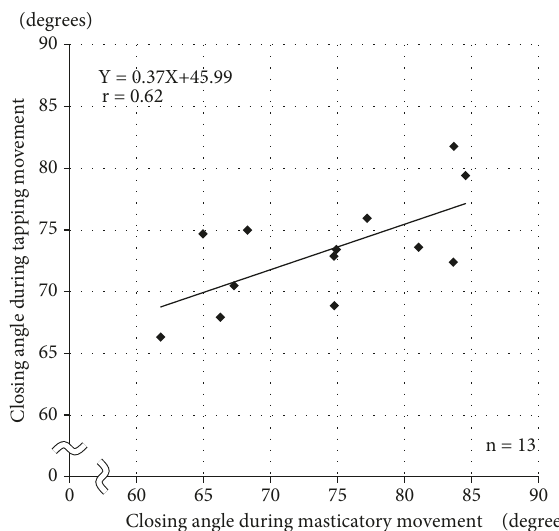
Figure 5: Correlation between closing angles during masticatory movement and tapping